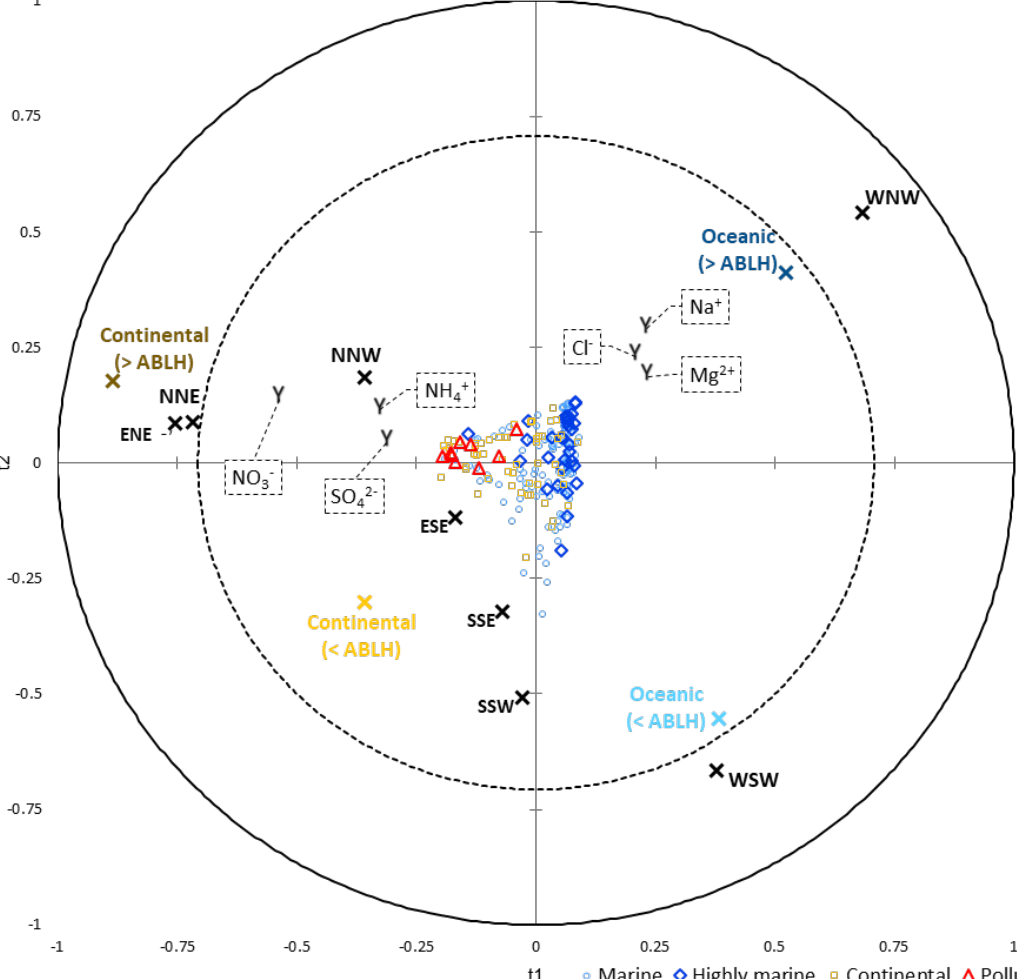
Figure 7. Partial least squares (PLS) chart with t component on axes t1 and t2. The correlations map superimposes the “Xs”, the “Ys” and the cloud events. The dependent variables from the chemical matrix are symbolized by a black “Y”; the explanatory variables from the “sector matrix” by a black “X”; and from the “zone matrix” by a blue, brown, light or dark “X”. The 208 cloud events are gathered by AHC category (red circle, “marine”; dark blue diamond, “highly marine”; yellow square, “continental”; and red triangle, “polluted”).